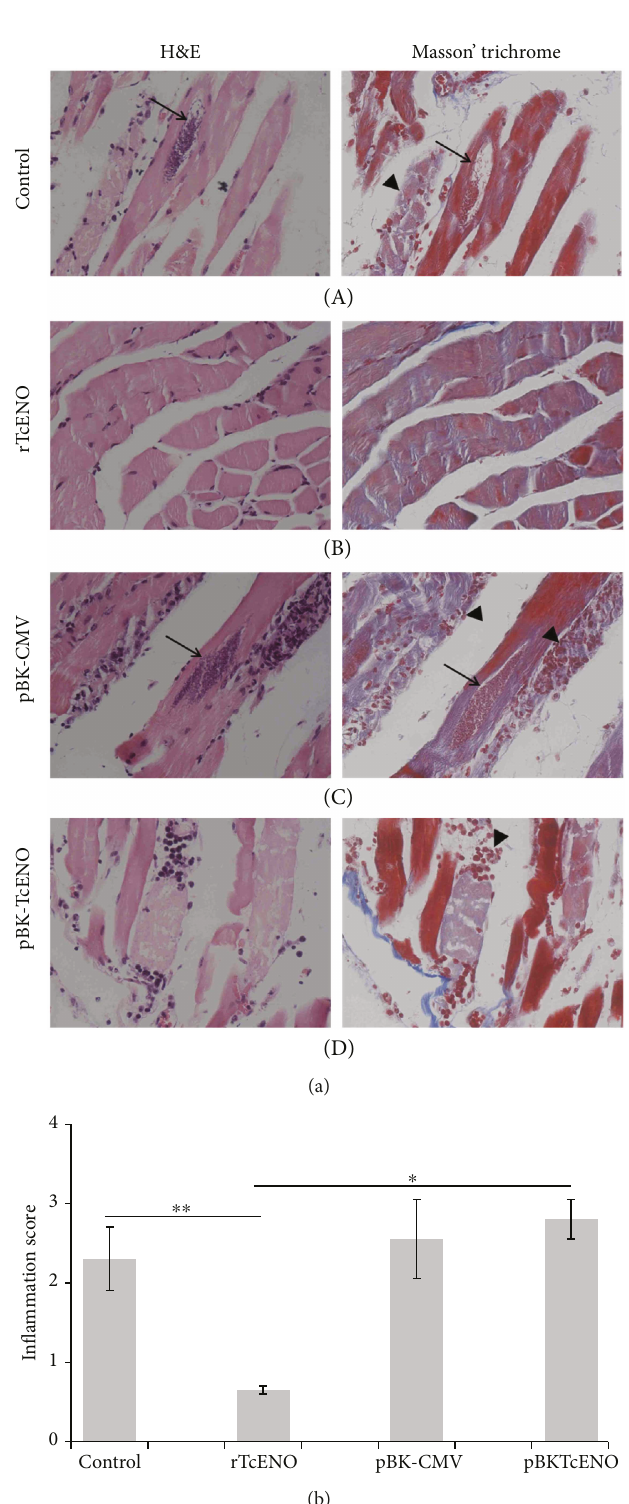
Figure 7: Vaccination e ff ects on the skeletal muscle sections. (a) Tissue sections were stained with hematoxylin and eosin or Masson ’ s trichrome and visualized by light microscopy (original magni fi cation: 40x). Representative micrographs of skeletal tissue from control- infected mice and mock-immunized with PBS (A), rTcENO (B), pBK-CMV empty plasmid vector (C), and pBK-TcENO (D) are shown. Black arrows show amastigote nests. Black arrowheads show in fl ammatory in fi ltrates. (b) In fl ammatory lesion (lymphocyte in fi ltrates) scores. The in fl ammatory score was derived from two di ff erent experiments as described in Materials and Methods. The data are expressed as mean ± SD, and signi fi cance is presented as ∗ p < 0 01 and ∗∗ p < 0 05 ( ∗∗ control group nonimmunized and infected versus vaccinated and infected groups, rTcENO and pBK-TcENO; ∗ rTcENO versus